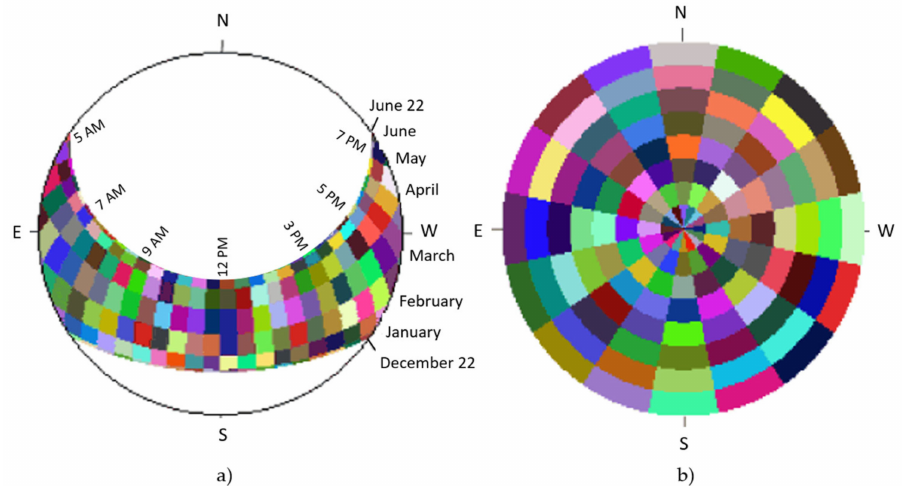
Figure 14. Examples of viewshed modelling results: ( a ) sun map for 45 ◦ N, calculated for the period between the winter solstice (21 December) and the summer solstice (21 June); the illustration shows that the position of the sun in the sky changes throughout the year depending on the time of day and month; ( b ) sky map divided into sectors—eight zenith angles and 16 azimuths; each colour represents a unique sector or part of the sky from which the scattered radiation comes (random colours)